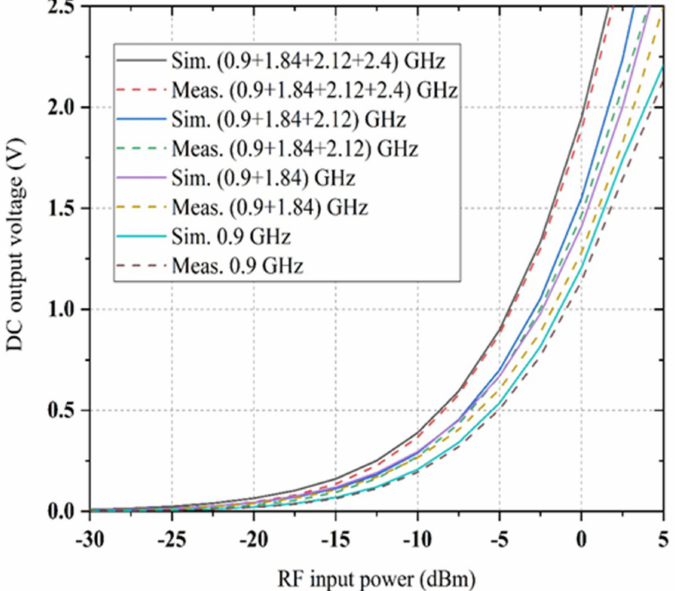
Figure 21. The comparison between simulated and measured output voltage versus input RF power for several